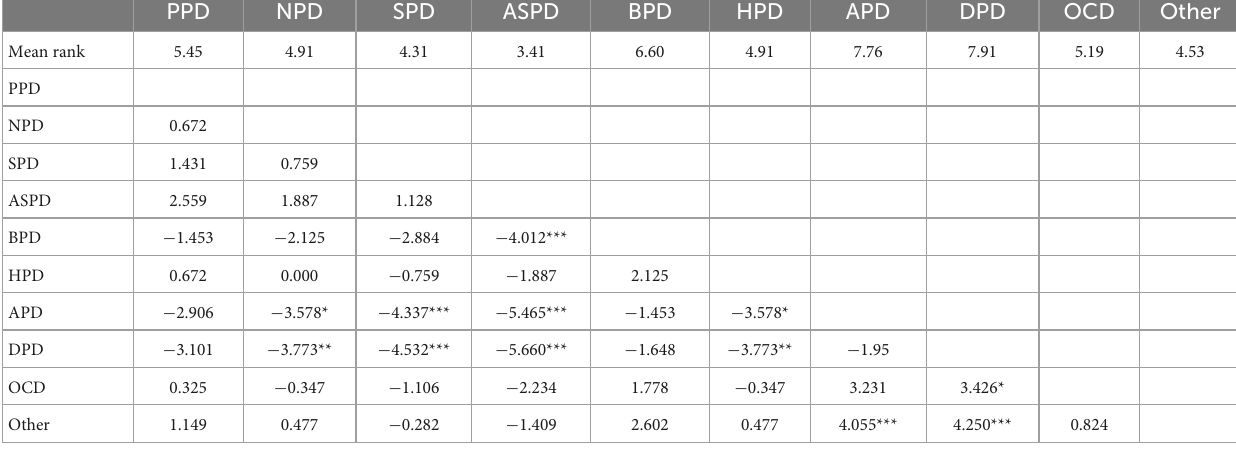
TABLE 2 Male clinicians’ likelihood of diagnosis in cases with vulnerable narcissism